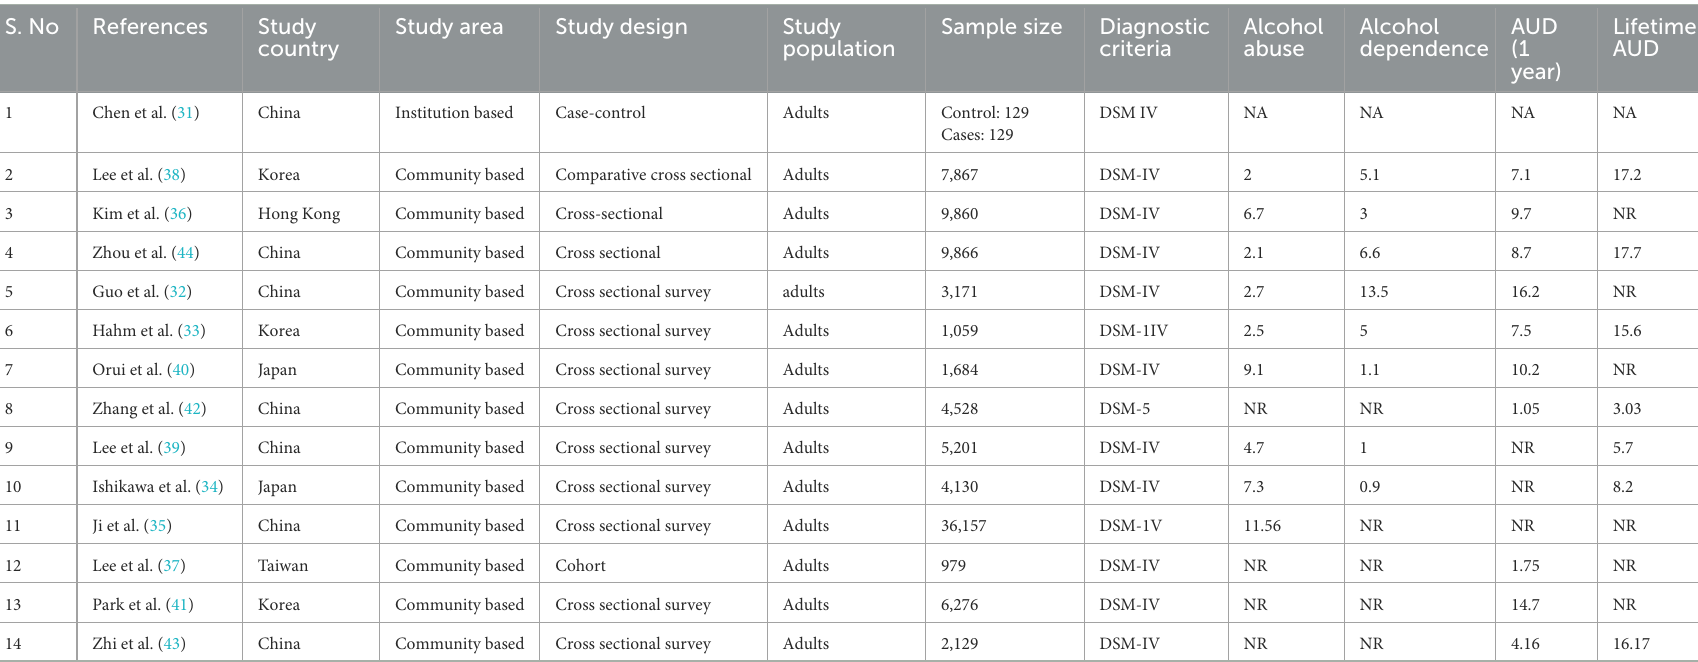
TABLE 1 Characteristics of included articles in this systematic review and meta-analysis ( n = 14). S.